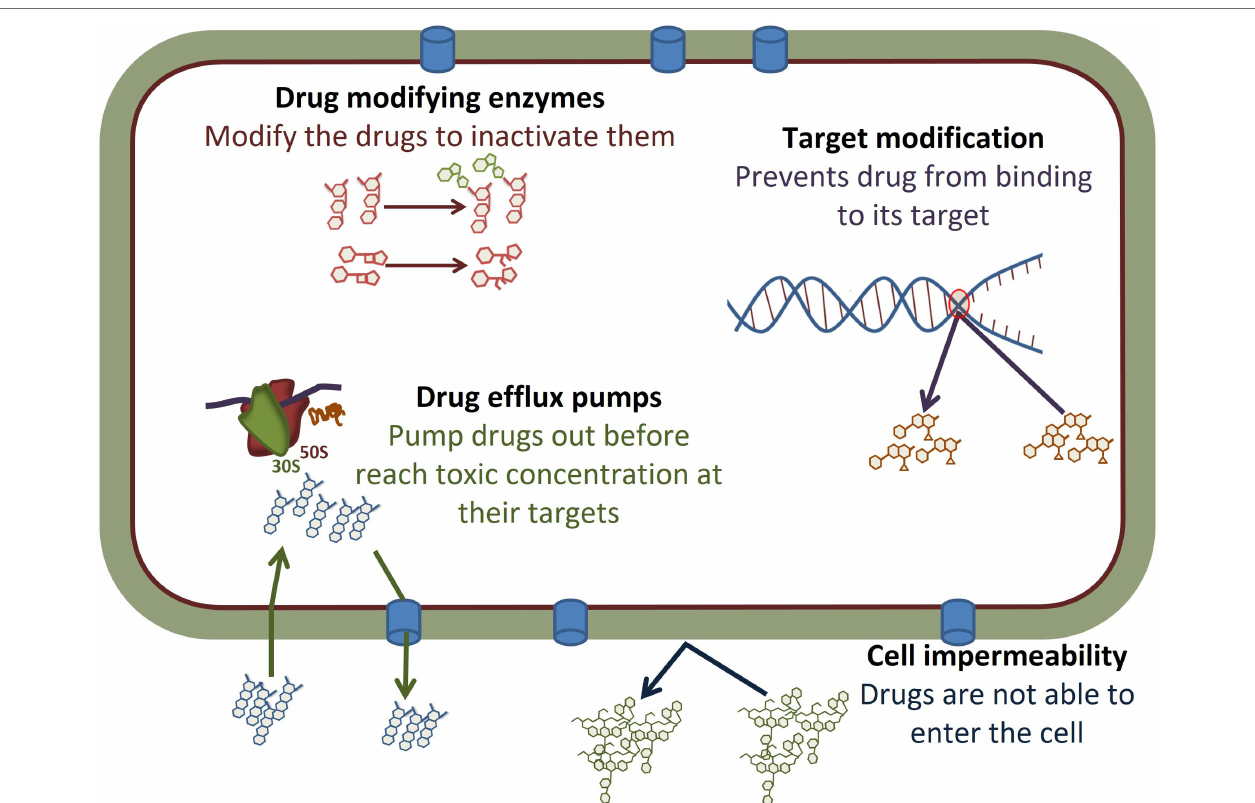
FIGURE 2 | Antimicrobial resistance mechanisms observed in Salmonella . The different mechanisms are described in detail in the body of the manuscript. Briefly, drugs such as many aminoglycosides can be modified by the addition of functional groups, while others such as β -lactam antibiotics can be cleaved by enzymes, thus modifying their structures and inhibiting function. Target modification, such as can occur in metabolic pathways or in the nucleic acid replication machinery, can limit the ability of antimicrobials to bind to their targets to prevent efficacy. A number of other drugs are impacted by drug efflux pumps that prevent drugs such as tetracyclines and chloramphenicol from reaching their targets, such as the ribosomes, in a high enough concentration which limits their effectiveness. Other drugs, such as vancomycin, are too large to enter through the Gram-negative cell wall and Salmonella are intrinsically resistant due to inability to enter the